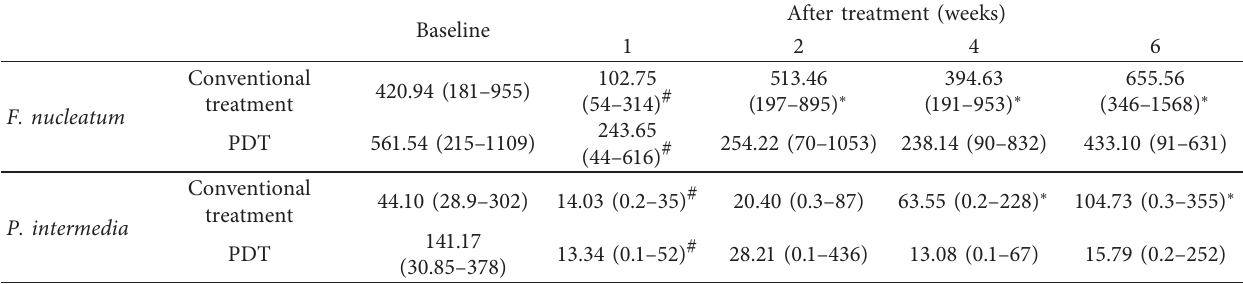
Table 3: Median and interquartile range of bacterial unit from baseline through 6 weeks of follow-up of the study groups. Baseline